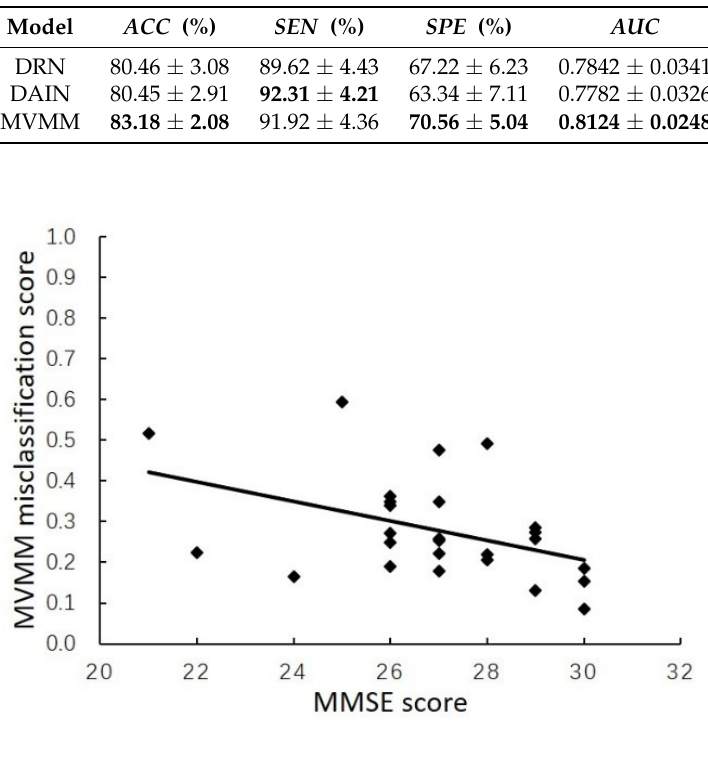
Figure 4. Relationship between the score of MCI being misclassified as AD and MMSE